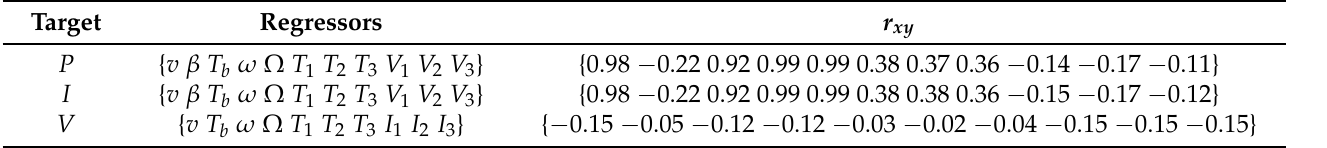
Figure 6. Comparison between Ref and Tar after the replacement of the Tar generator: data set D after . Table 4. Correlation coefficients r xy for the D fault data set.